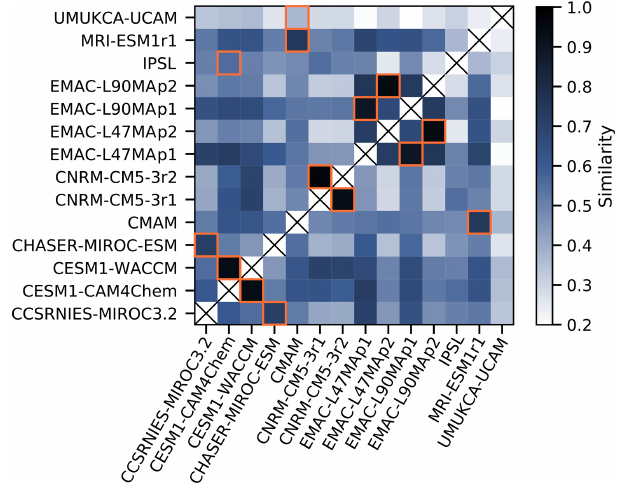
Figure 5. Inter-model similarity across all refC1SD models as cal- culated by Eq. (3). A similarity of 1 denotes models which are iden- tical for all the metrics, whereas a lower similarity shows a greater independence. The orange boxes highlight the model most similar to the model on the y